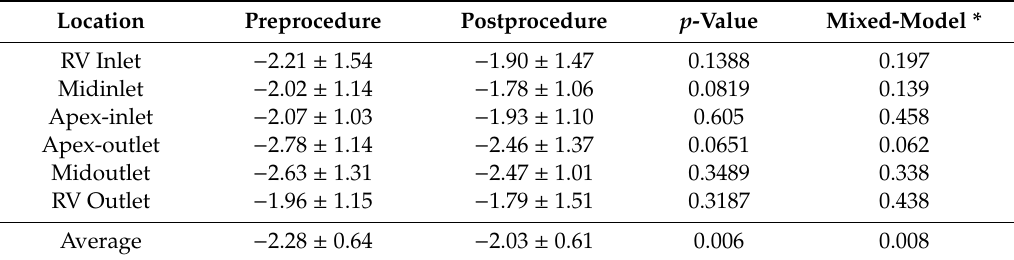
Table 4. Change of SR in each RV segment on VVI (1 / s) after ASD device